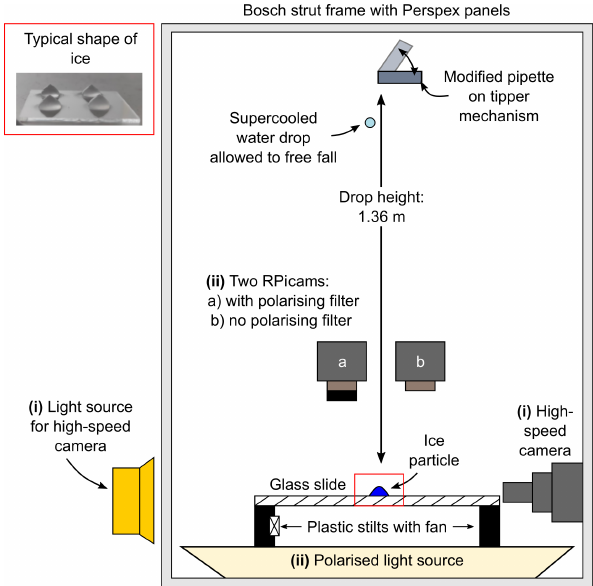
Figure 1. Schematic diagram of the experimental setup. Compo- nents labelled (i) were used in the high-speed configuration and (ii) were used in the RPicam configuration. The setup was operated in a cold room to achieve a supercooled environment.